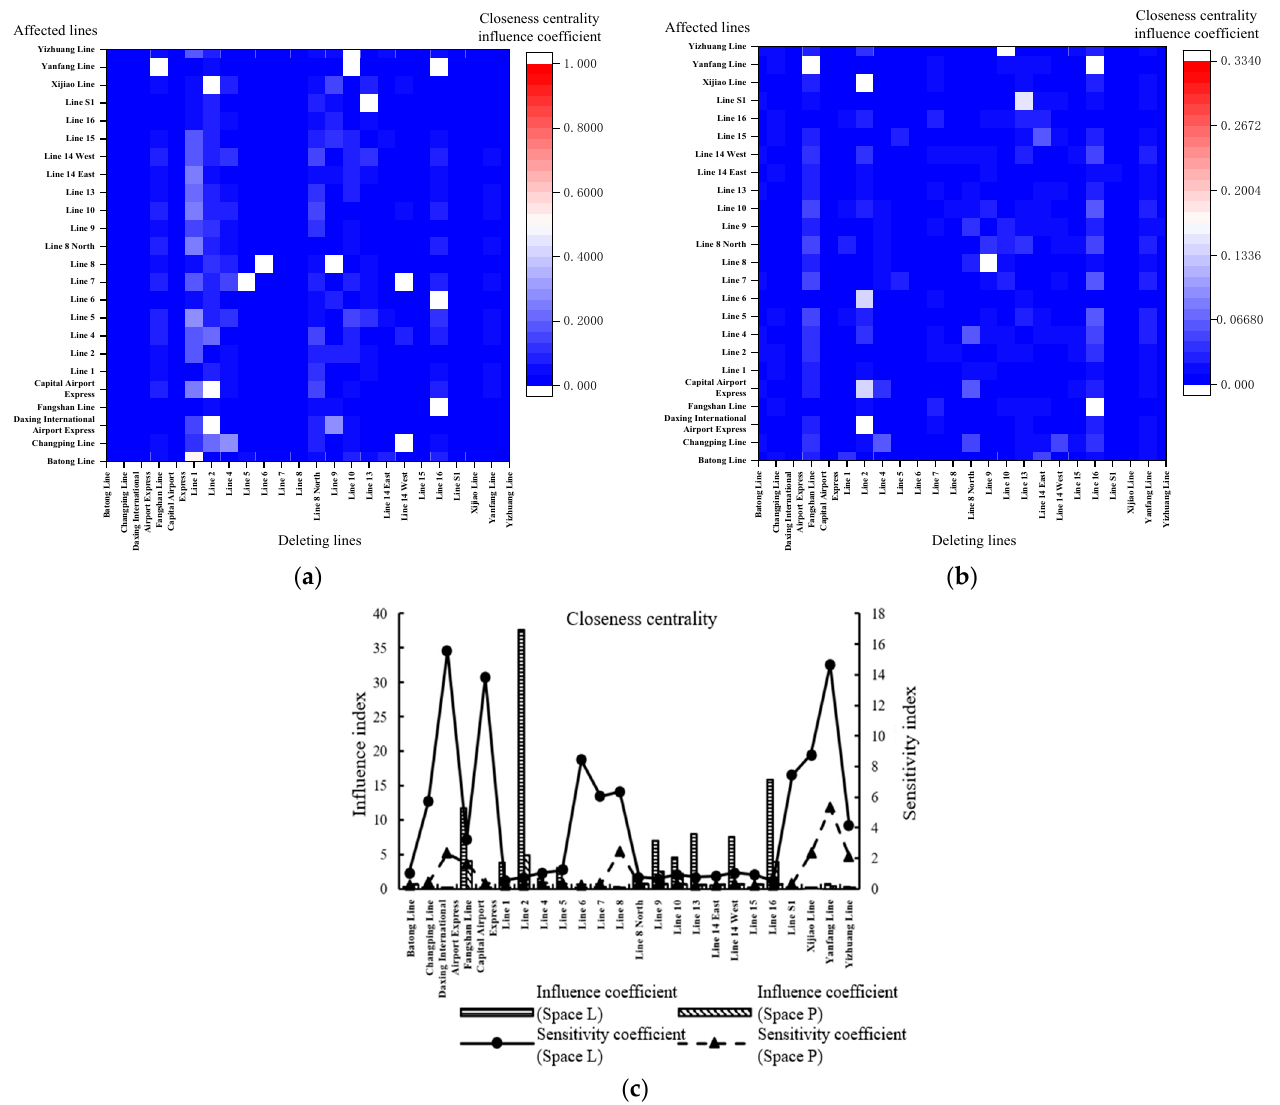
Figure 9. Near-centrality influence and sensitivity coefficient. ( a ) Near-centrality influence coefficient between lines (Space L). ( b ) Centrality influence coefficient between lines (Space P). ( c ) Near-centrality influence and sensitivity coefficient.